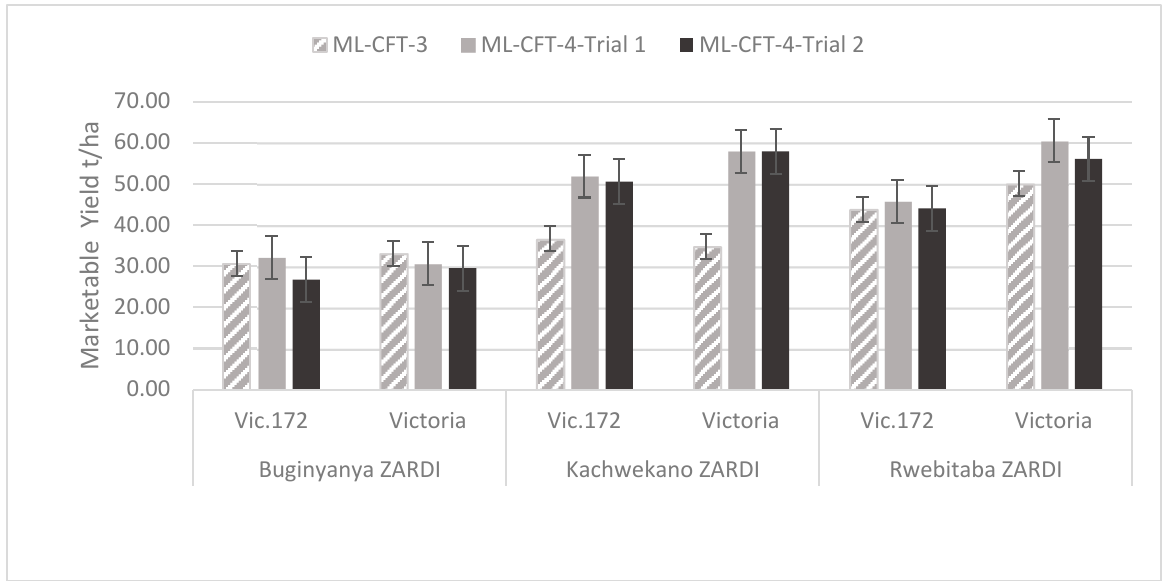
Figure 5. Marketable yield of transgenic event Vic.172 and the variety Victoria at each of the three locations averaged over the three trials. Error bar represents the standard error.